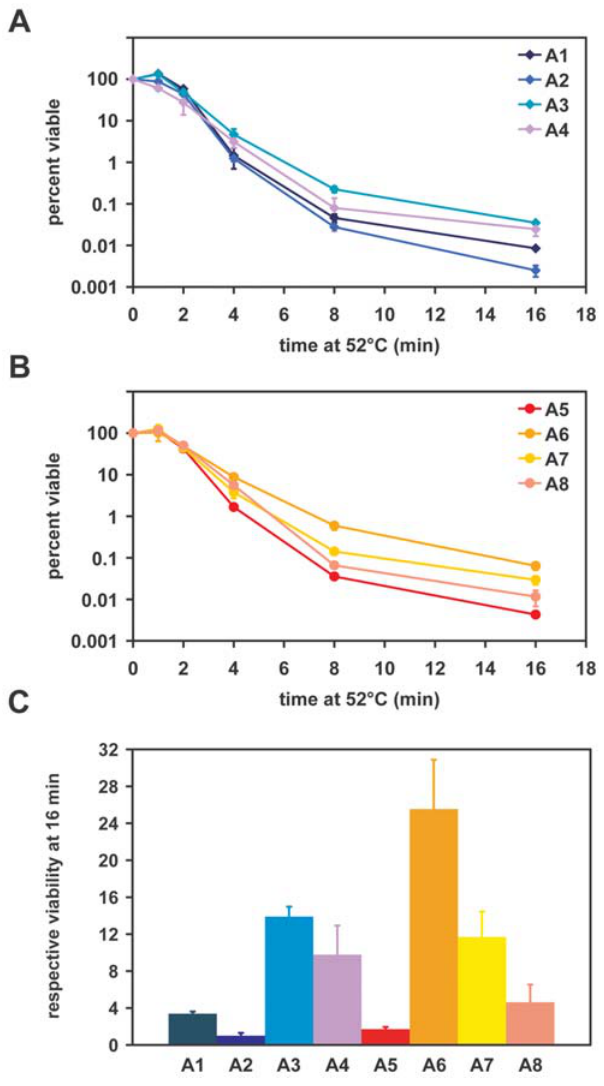
Figure 3. Thermoresistance properties of strains expressing individual Ssaps. The indicated strains were grown to early exponential phase at 28 u C then shifted at 52 u C. (A, B) Aliquots were periodically removed and cell viability was assessed by plating tenfold serial dilutions onto YPAD plates. (C) The viability of each strain at the 16 min time point was expressed as a fold enrichment over that of A2 which was arbitrarily set to 1.